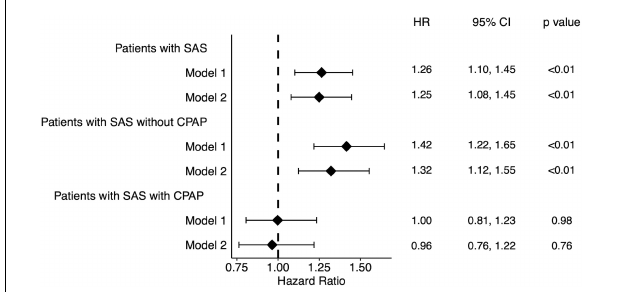
FIGURE 2 | Forest plot of hazard ratio for patients with SAS. Patients with SAS showed a high hazard ratio. Among them, those treated with CPAP showed no significant difference in hazard ratios compared to the group without SAS. Model 1: without adjustment. Model 2: Adjusted by age, sex, potassium, eGFR and albumin. SAS, sleep apnea